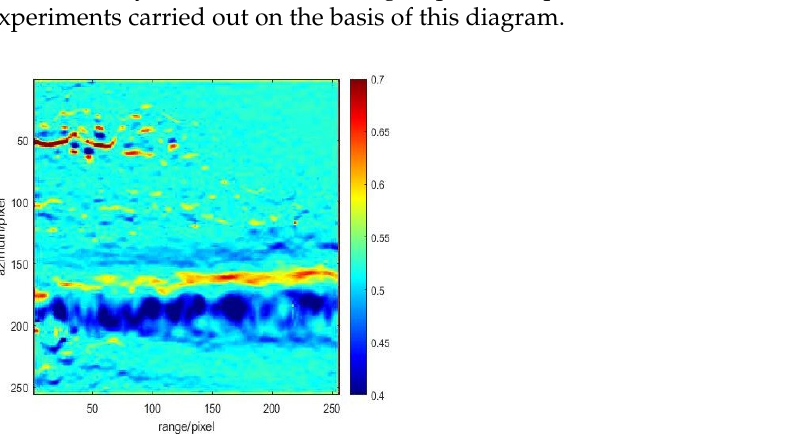
Figure 7. The control group of the input ocean surface current field velocity.